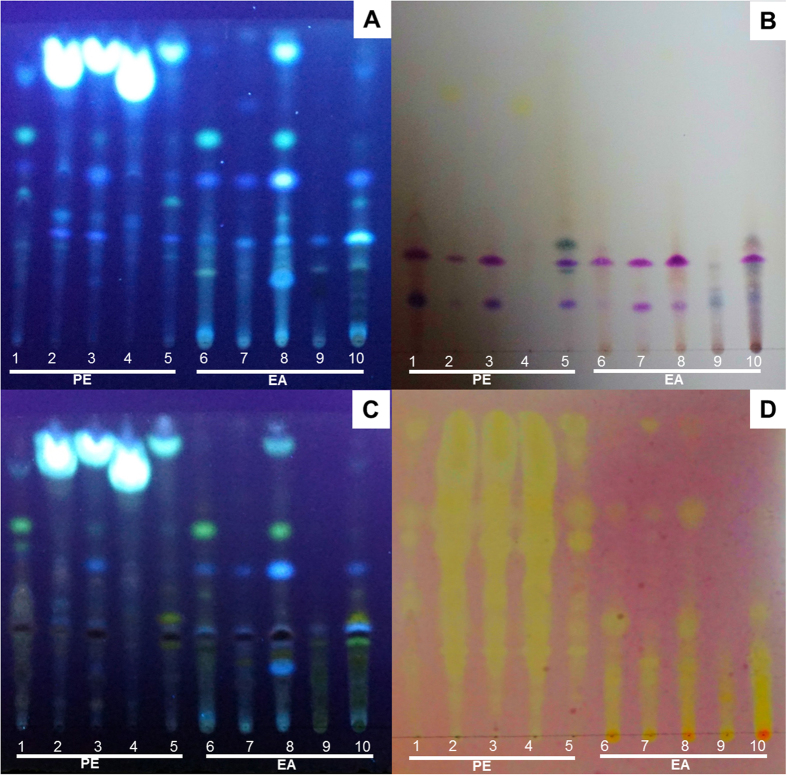
TLC photography of fungal endophytic extractions.The petroleum ether (PE, 30–60 °C) and ethyl acetate (EA) fractions extracted from strains 4WBY1 (1 and 6), 6WBY3 (2 and 7), 7WBY2 (3 and 8), WBS019 (4 and 9) and WBS020 (5 and 10). These fractions were developed in a preselected solvent system containing trichloromethane/toluene/ethanol/formic acid (4:4:0.5:0.1, by volume) and visualised using several methods, namely, ultraviolet lamps at 365 nm (A), heating for 3 min at 105 °C after spraying with vanillin sulphuric acid (B), ultraviolet lamps emitting at 365 nm after spraying with 2% aluminium chloride solution (C) and 0.04 mg·mL−1 DPPH in ethanol (D).